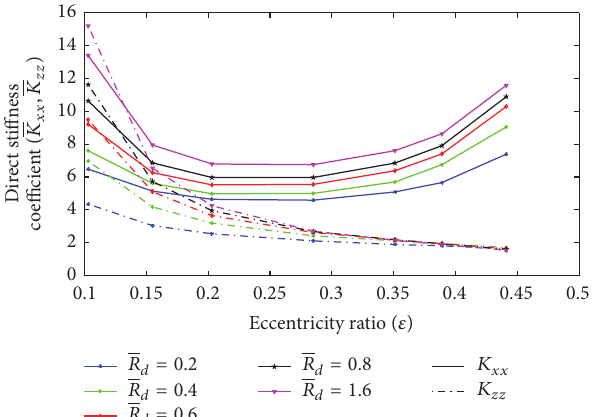
Figure 10: Effect of relief track depth ratio on direct damping